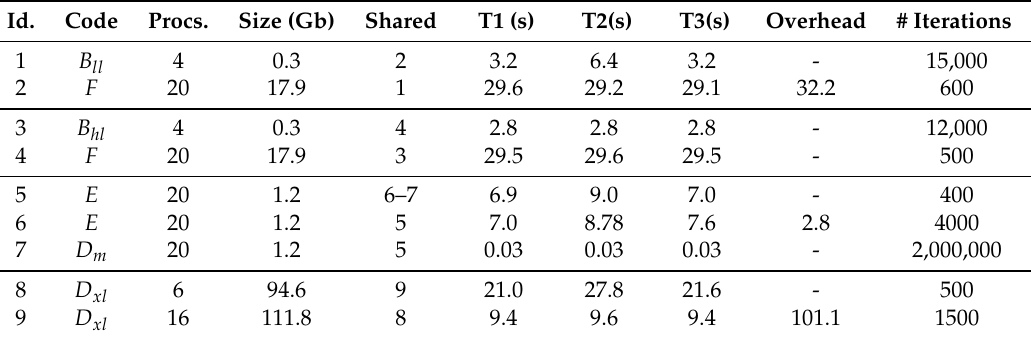
Table 2. Use case example of interference. T1, T2, T3 are the execution times per 10 iterations. Overhead is the application reconfiguration overhead measured in